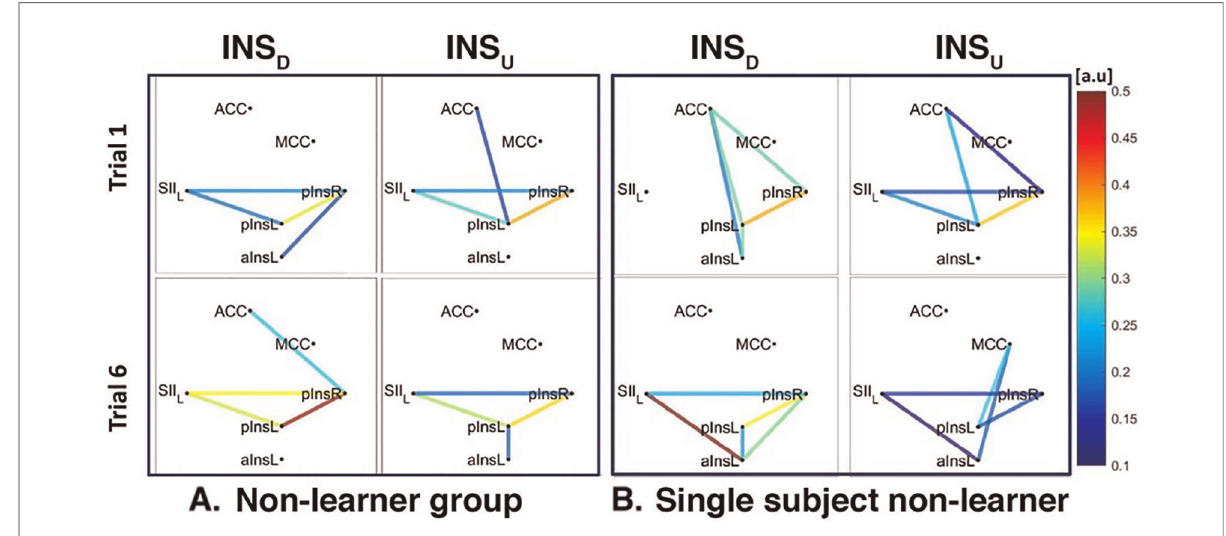
FIGURE 8 Connectivity strengths identi fi ed using the Coherence analysis for the Ins condition for the non-Learner group ( A ) and for a representative non- Learner ( B ) in the fi rst trial (Trial 1, top) and in the last trial (Trial 6, bottom). The colors from blue to red indicate weak to strong connection strength respectively and are expressed in arbitrary units